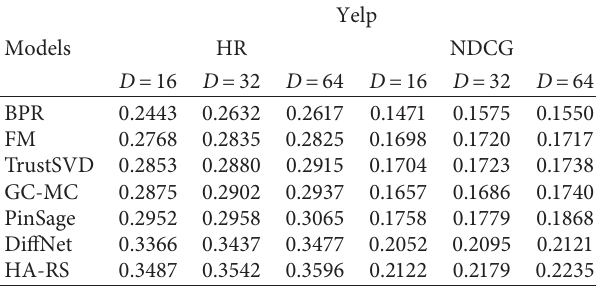
Table 3: HR@10 and NDCG@10 comparisons for different di- mension sizes D.